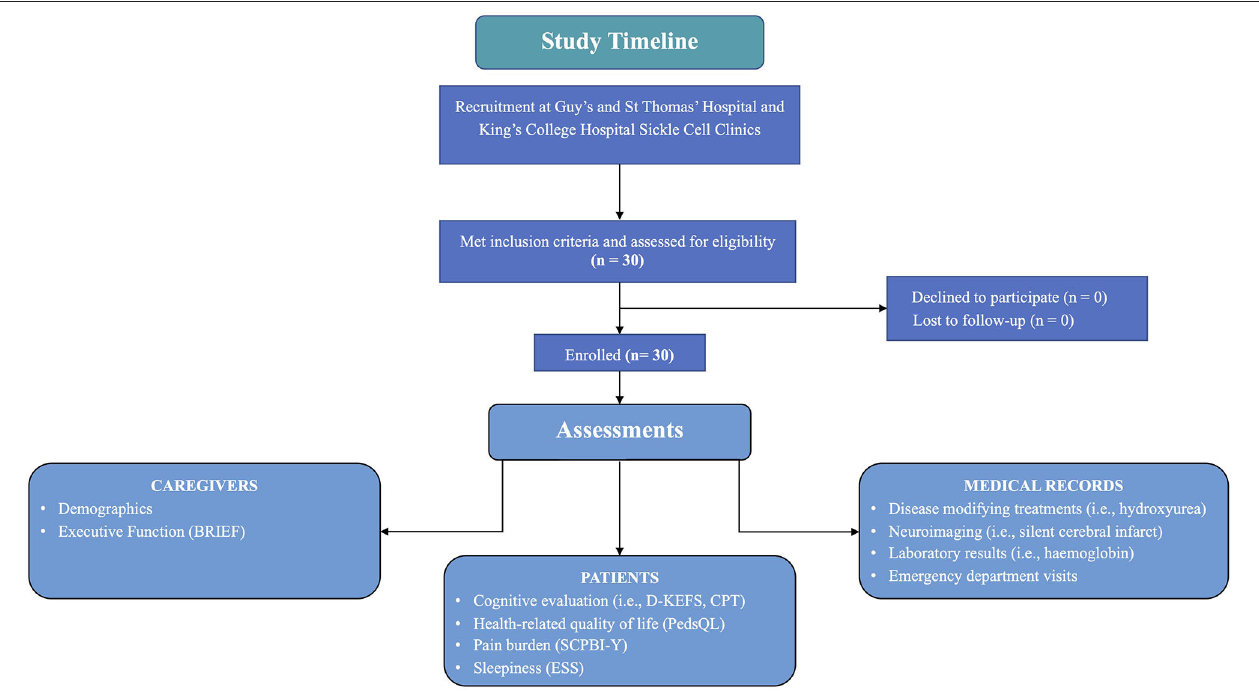
FIGURE 1 | Study timeline. SCPBI-Y, Sickle Cell Pain Burden Interview-Youth; Conners’ Continuous Performance Test-Third Edition, CPT-3; PedsQL, Paediatric Quality of Life Inventory HRQOL; DKEFS, Delis-Kaplan Executive Function System; BRIEF GEC, Behavioural Rating Inventory of Executive Function Global Executive